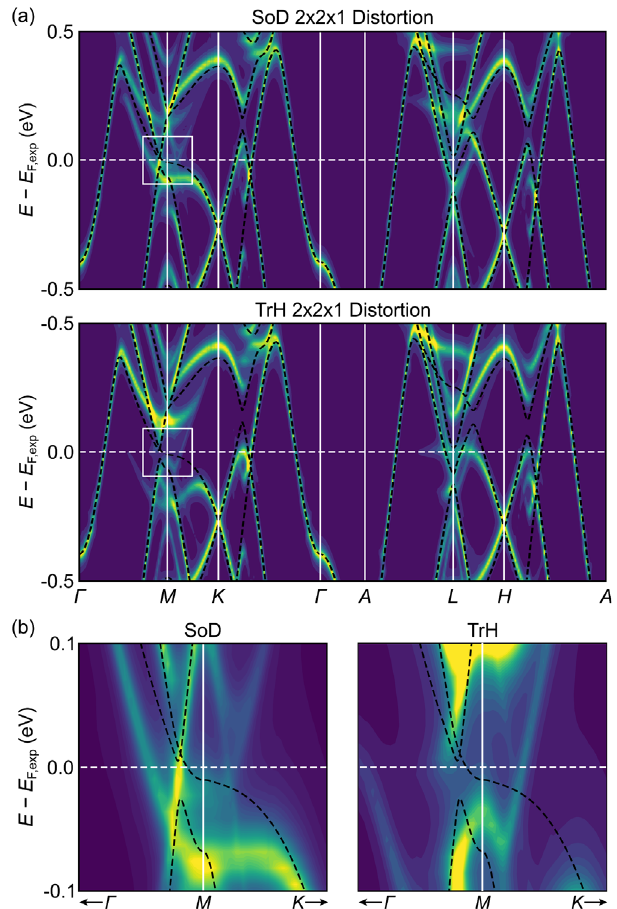
FIG. 4. (a) Unfolded electronic structure of the SoD and TrH distortions in CsV 3 Sb 5 with the undistorted electronic structure superimposed for comparison (black). The largest perturbation to the structure appears near the Dirac-like bands near M. (b) Close- up of the changes near the M point, highlighting the new bands that appear as a result of the CDW and the associated structural